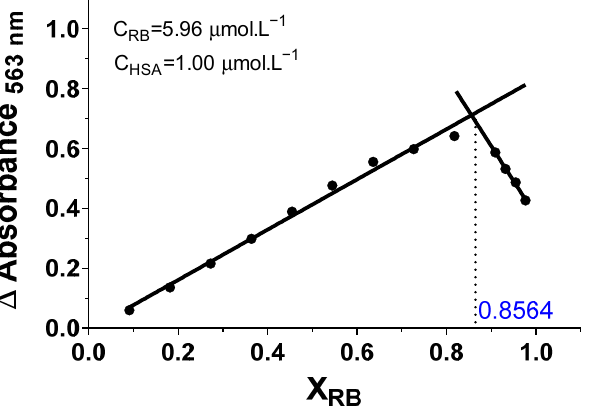
Figure 4. Result of the Job’s Plot test referring to the values of the molar fractions of the RB dye ( λ = 563 nm).